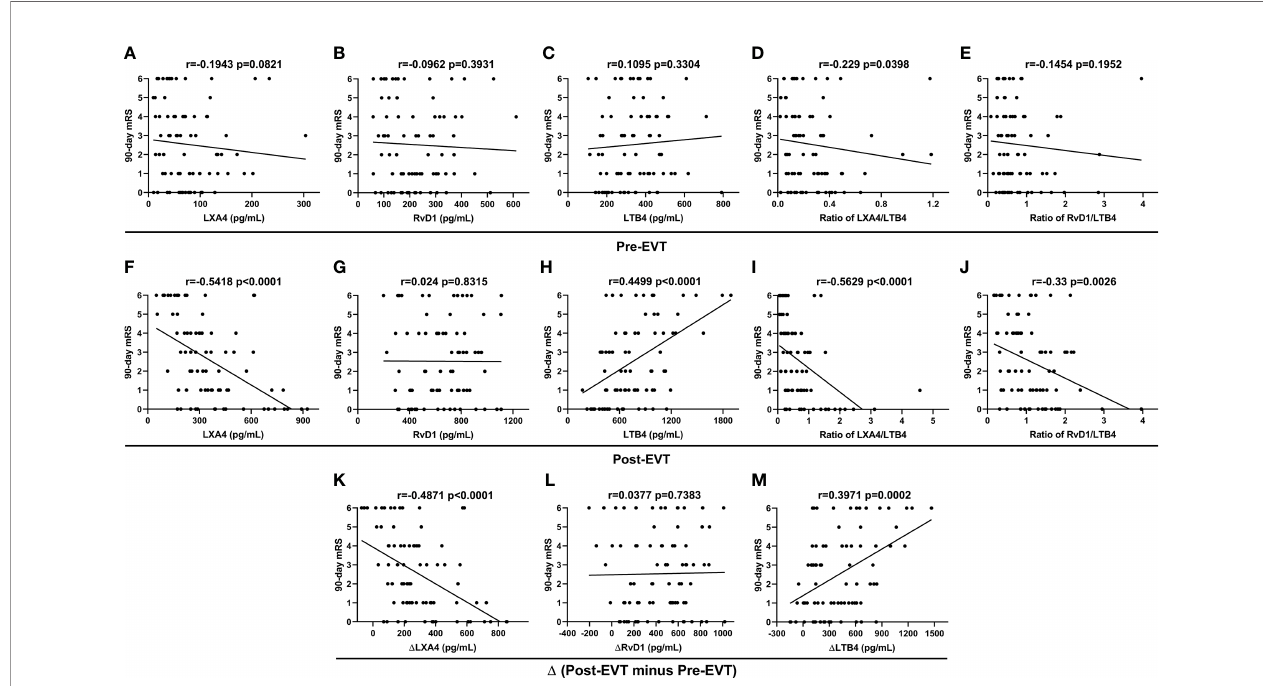
FIGURE 3 | Spearman correlation coef fi cient analyses of correlation between plasma lipid mediatorparameter levelsin EVT-treated AIS patients and 90-day mRS